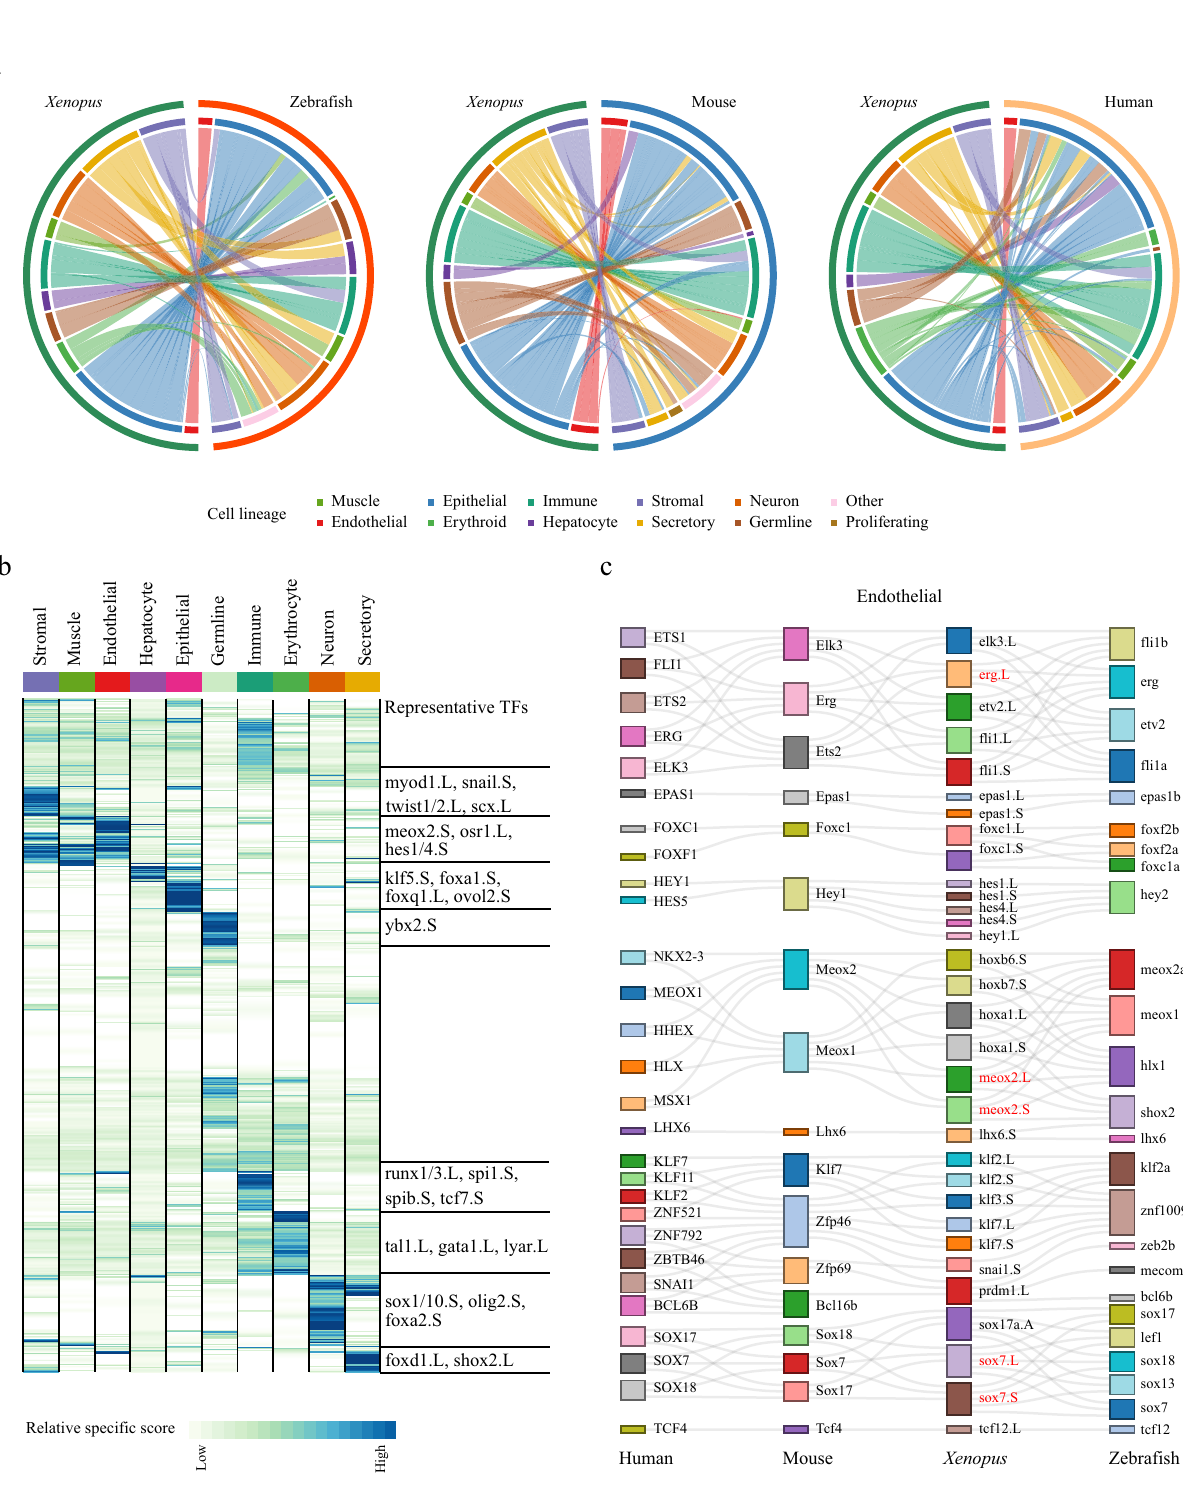
Fig. 3 Cell-type evolution between adult Xenopus , zebra fi sh, and mammals. a Circle plot showing the similarity of cell lineages in Xenopus laevis , zebra fi sh (left), mice (middle), and humans (right). Pairs of cell types with mapping scores greater than 0.1 are connected by lines. Cell lineages are labeled in different colors. b Heatmap showing the speci fi c scores of TFs in Xenopus for each cell type. Each row represents one TF, and each column represents one cell lineage. Cell lineages are labeled in different colors. The representative TFs in each cell lineage are presented in the right panel. c Sankey plot showing common lineage-speci fi c transcription factors in endothelial for four vertebrates (humans, mice, Xenopus , and zebra fi sh). The representative TFs in Xenopus laevis are labeled by red. Different TFs in each species are marked in different color boxes. Homologous TFs between species obtained from SAMap are connected by